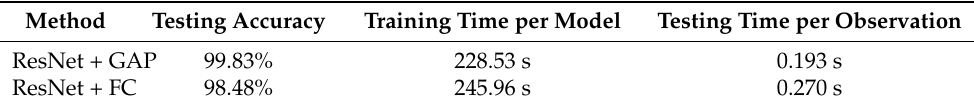
Table 3. Comparison of fault diagnosis results.